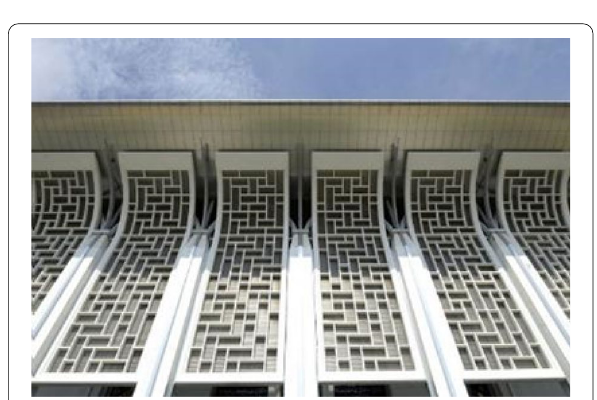
Fig. 13 The stainless-steel spiral mesh at the back of the rectangular pattern (GKD,